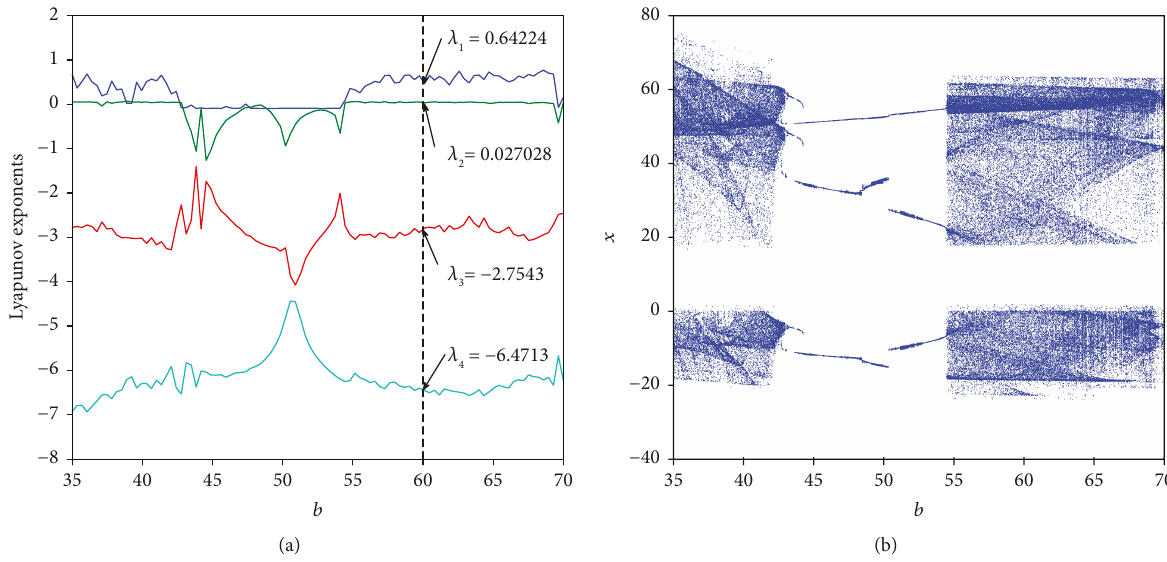
Figure 9: Lyapunov exponents and bifurcation diagram with respect to parameter b . (a) Lyapunov exponents diagram. (b) Bifurcation diagram.